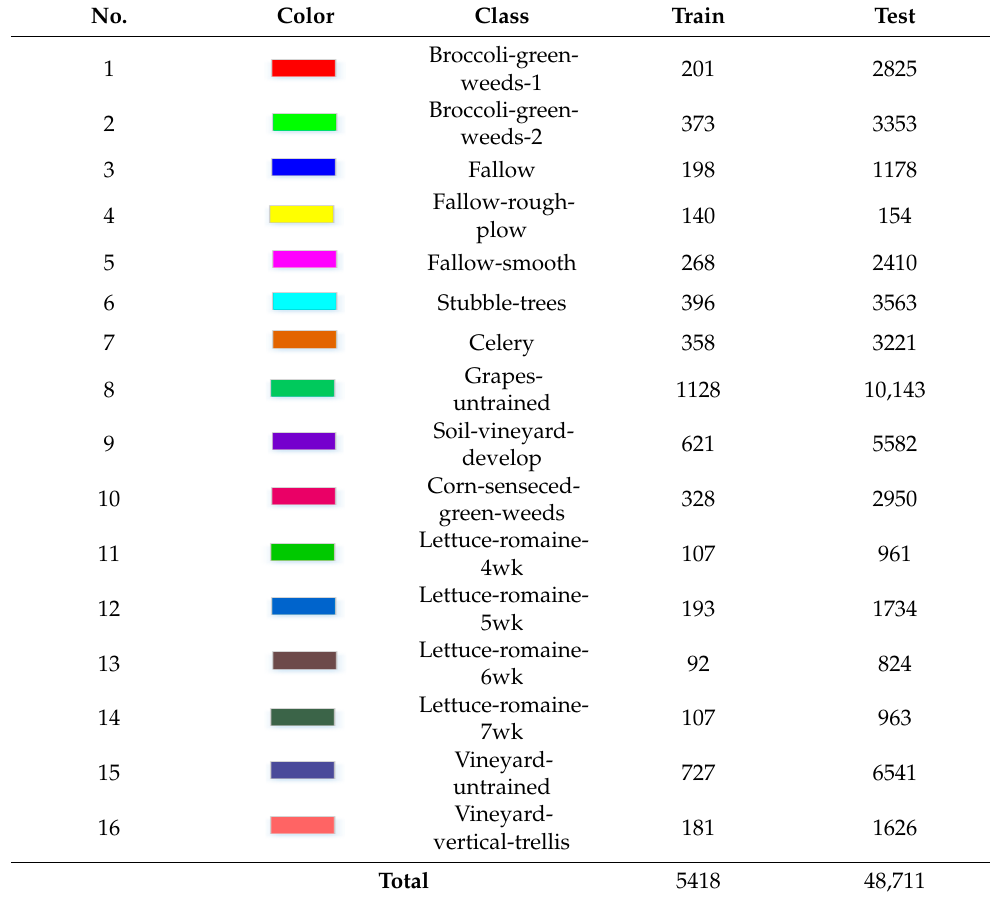
Table 4. Number of training and test samples of SA dataset. No.